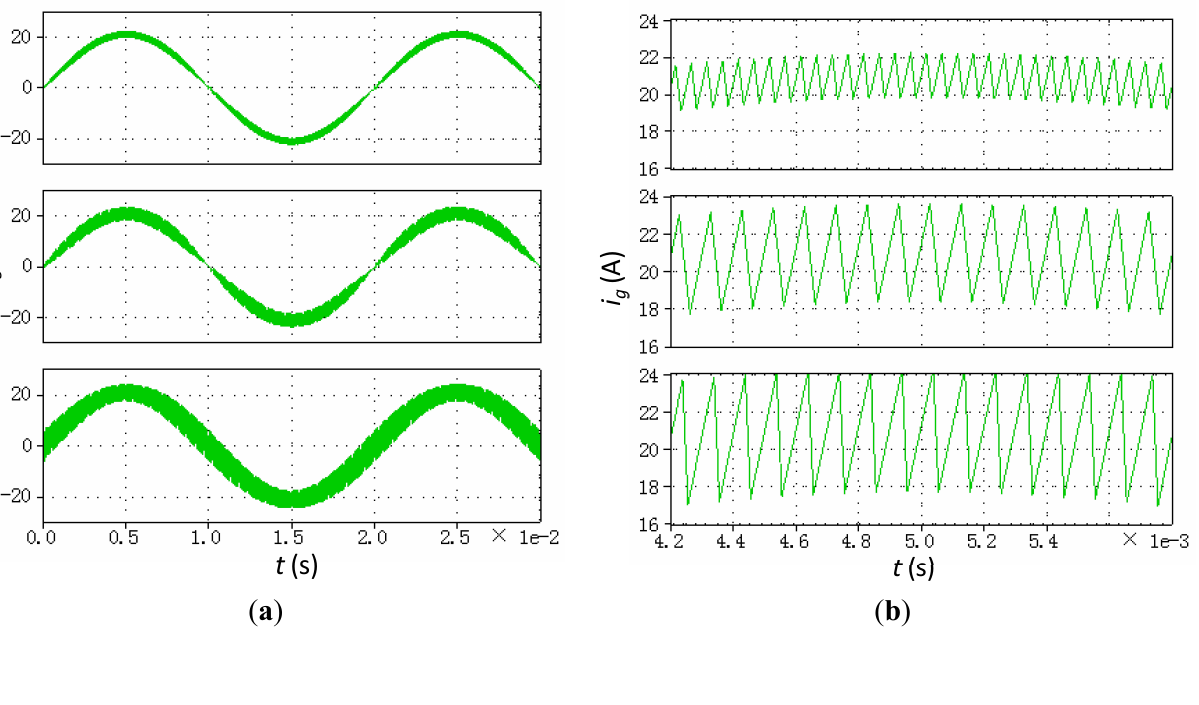
Figure 15. Grid-side current waveforms of BSS-FBC, single-phase PWM converters with unipolar and bipolar control: ( a ) Line-frequency view; ( b ) High-frequency